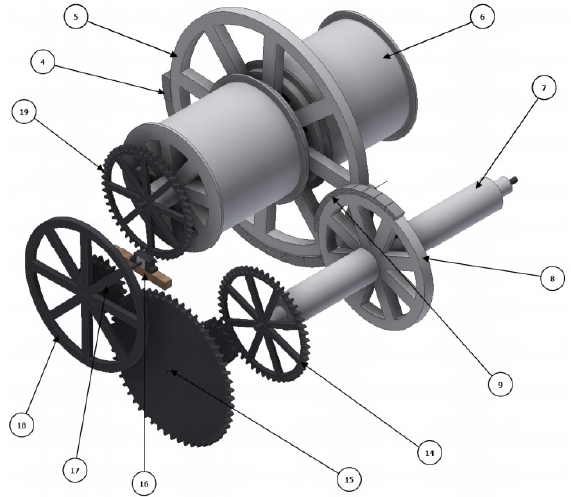
Figure 3. Detail of the transmission trees and gears of the